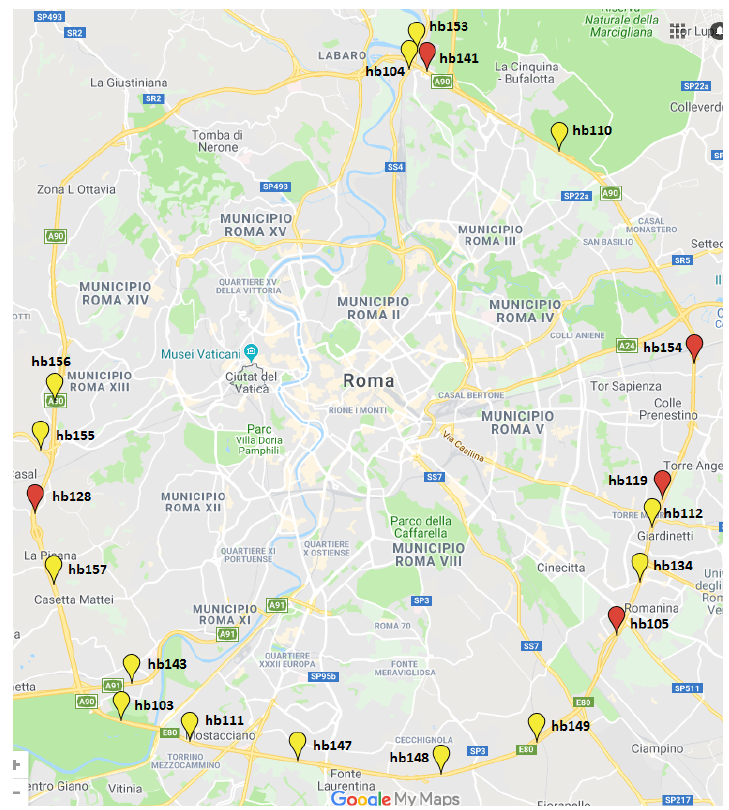
Figure 1. Map with sensor location information within the Wireless Acoustic Sensor Network (WASN) of DYNAMAP project.